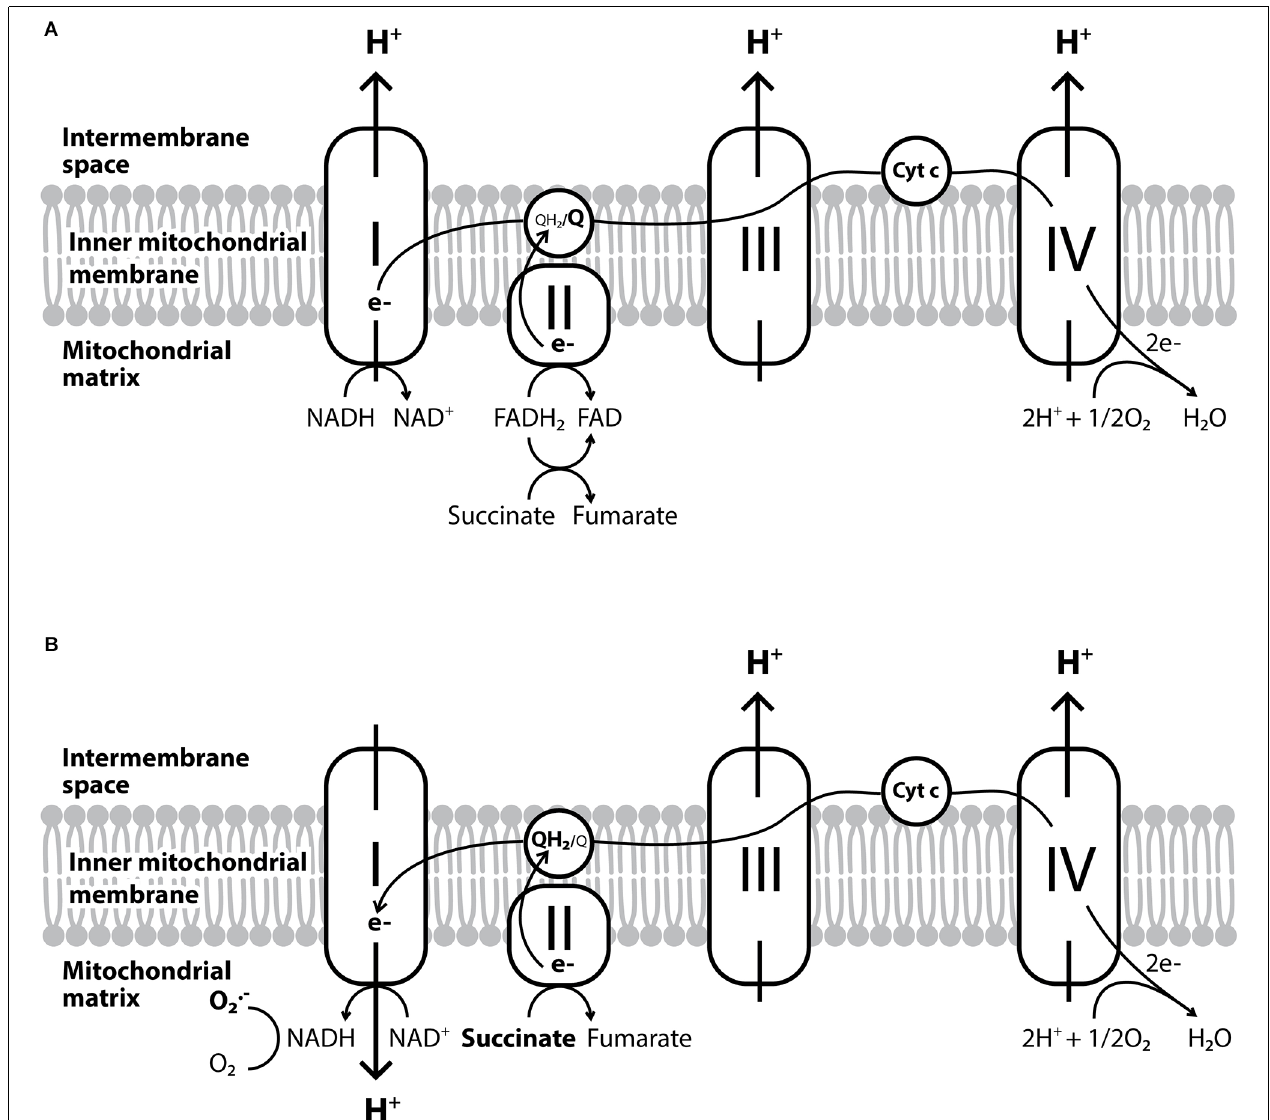
FIGURE 1 | The electron transport chain and the reverse electron transport. (A) The conventional forward electron transport by the electron transport chain. (B) The reverse electron transport which leads to the overproduction of O 2 •− and occurs when coenzyme Q gets over-reduced by complex II or the succinate is overused due to